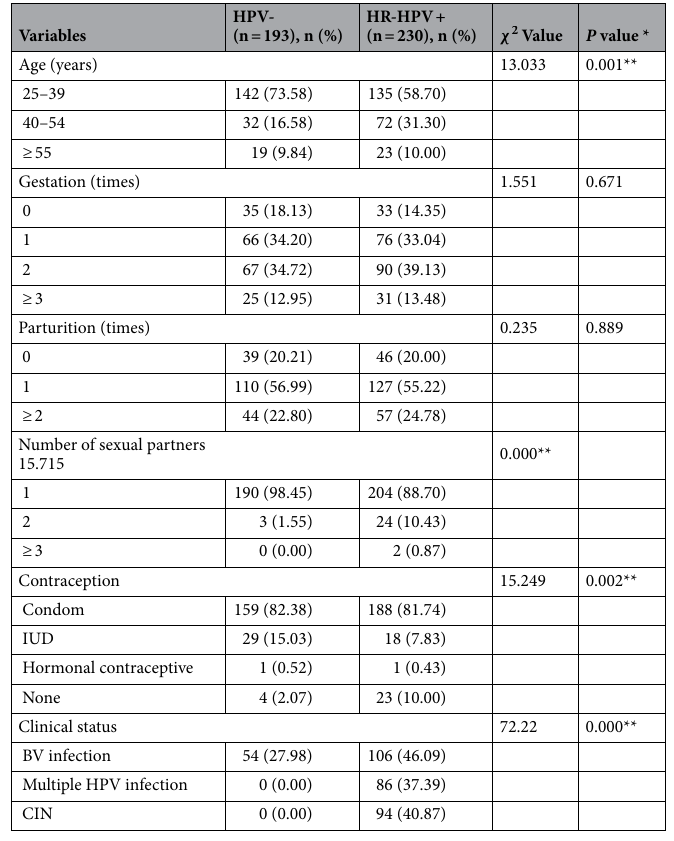
Table 1. Population characteristics by HPV status (total n = 423). All variables were showed as frequencies and proportions. HPV−: HPV (human papillomavirus)-negative; HPV + : HR-HPV positive; IUD: intrauterine device; BV: bacterial vaginosis; CIN: cervical intraepithelial neoplasia. * P values were calculated by Pearson 2 ) Chi-squared (χ test. ** statistically significant, P <